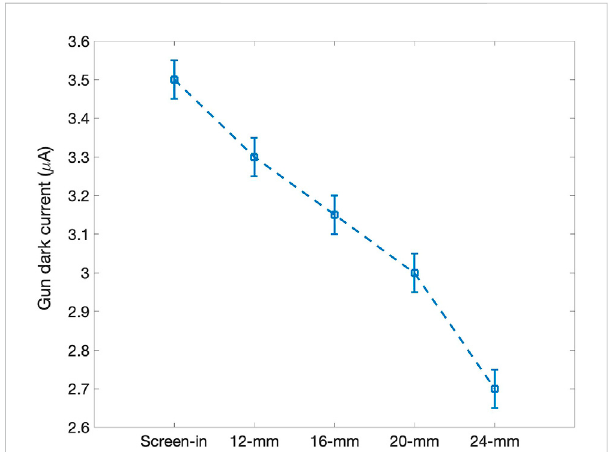
FIGURE 9 Cross section of the molybdenum cathode plug when inserted into the copper cathode nose. The likely dark current emission region is